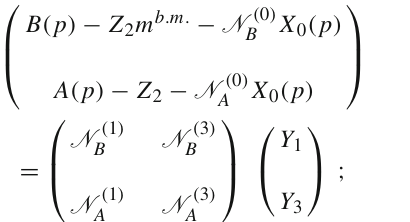
for c = 1 . 26, a = 0 . 80 GeV, b = 1 . 3 GeV and w